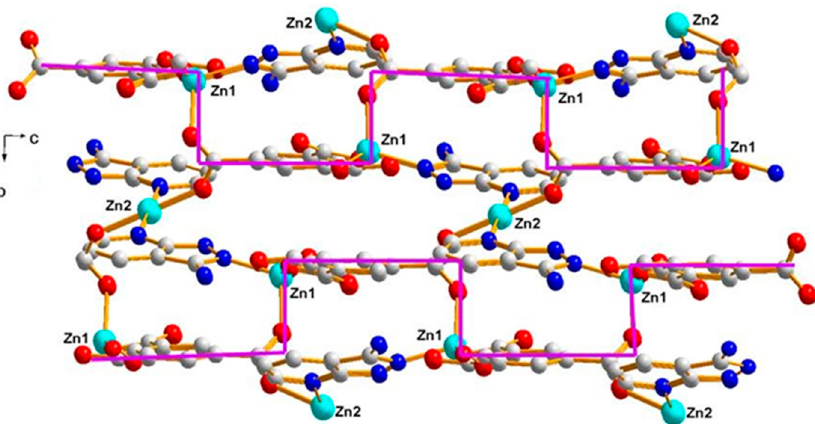
Figure 6. ( a ) Zn1(II) ions connected by the tridentate BTC 3 − ligands, which form a 2D structure of Polymer 2 viewed down the b -axis with the 6-connected net highlighted. ( b ) View down the a -axis of the 2D structure showing a square-wave chain structure, which is highlighted by the red line.